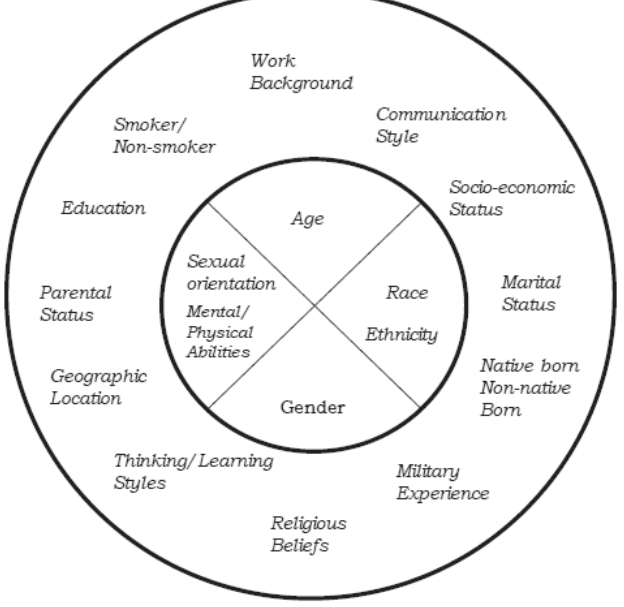
Fig. 1 - Primary and secondary elements of diversity. Source: Hubbard, 2004,